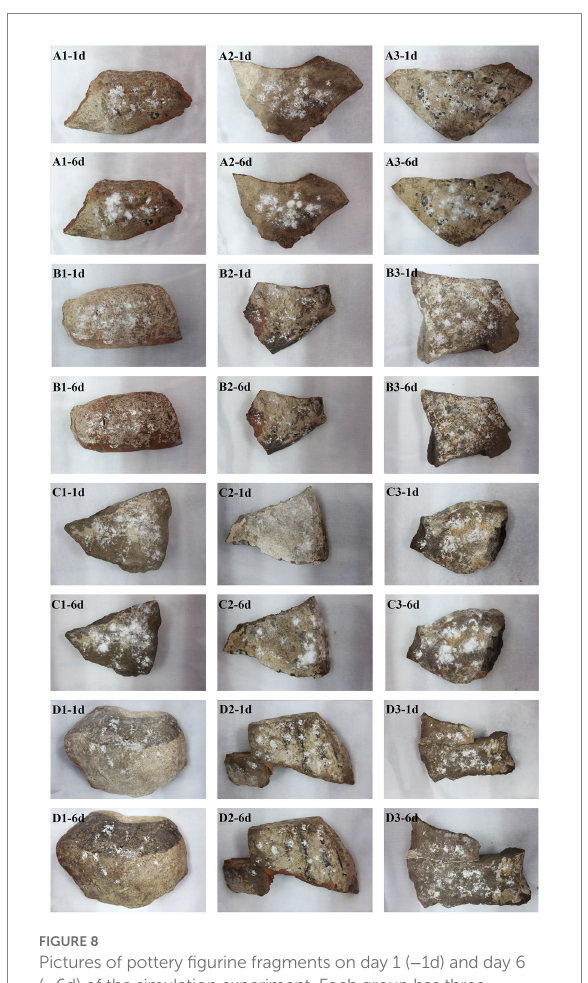
FIGURE 8 Pictures of pottery figurine fragments on day 1 ( − 1d) and day 6 ( − 6d) of the simulation experiment. Each group has three samples, and the same amount of NK-PF1 was added to each pottery figurine fragment. (A) Sprayed with 5 ml solvent of cinnamaldehyde (mixture of 1% dimethyl sulfate and 0.1% Tween-80) every day. (B) Sprayed with 5 ml 50 mg/ml cinnamaldehyde every day. (C) Sprayed with 5 ml ddH 2 O every day. (D) Sprayed with 5 ml 0.5% K100 every